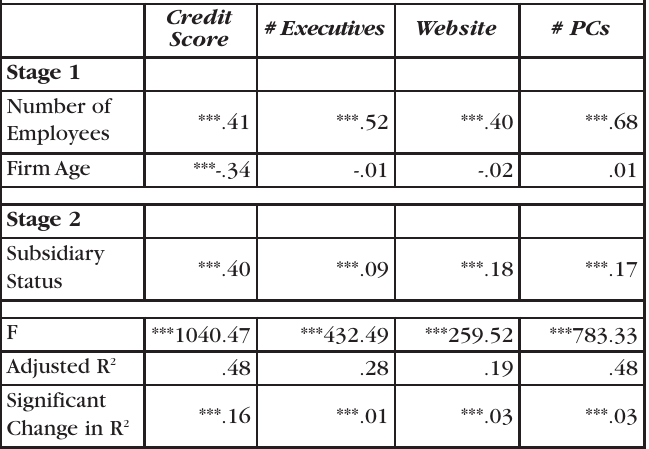
Table 2. Regression of Subsidiary Status on Credit Scores, Number of Executives, Presence of a Website, and Number of Personal